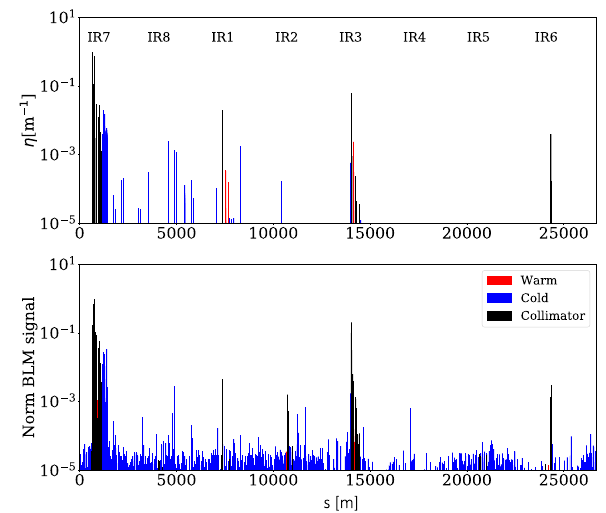
FIG. 11. Simulated (top) and measured (bottom) FT B1 horizontal 208 Pb 82 þ ion beam loss